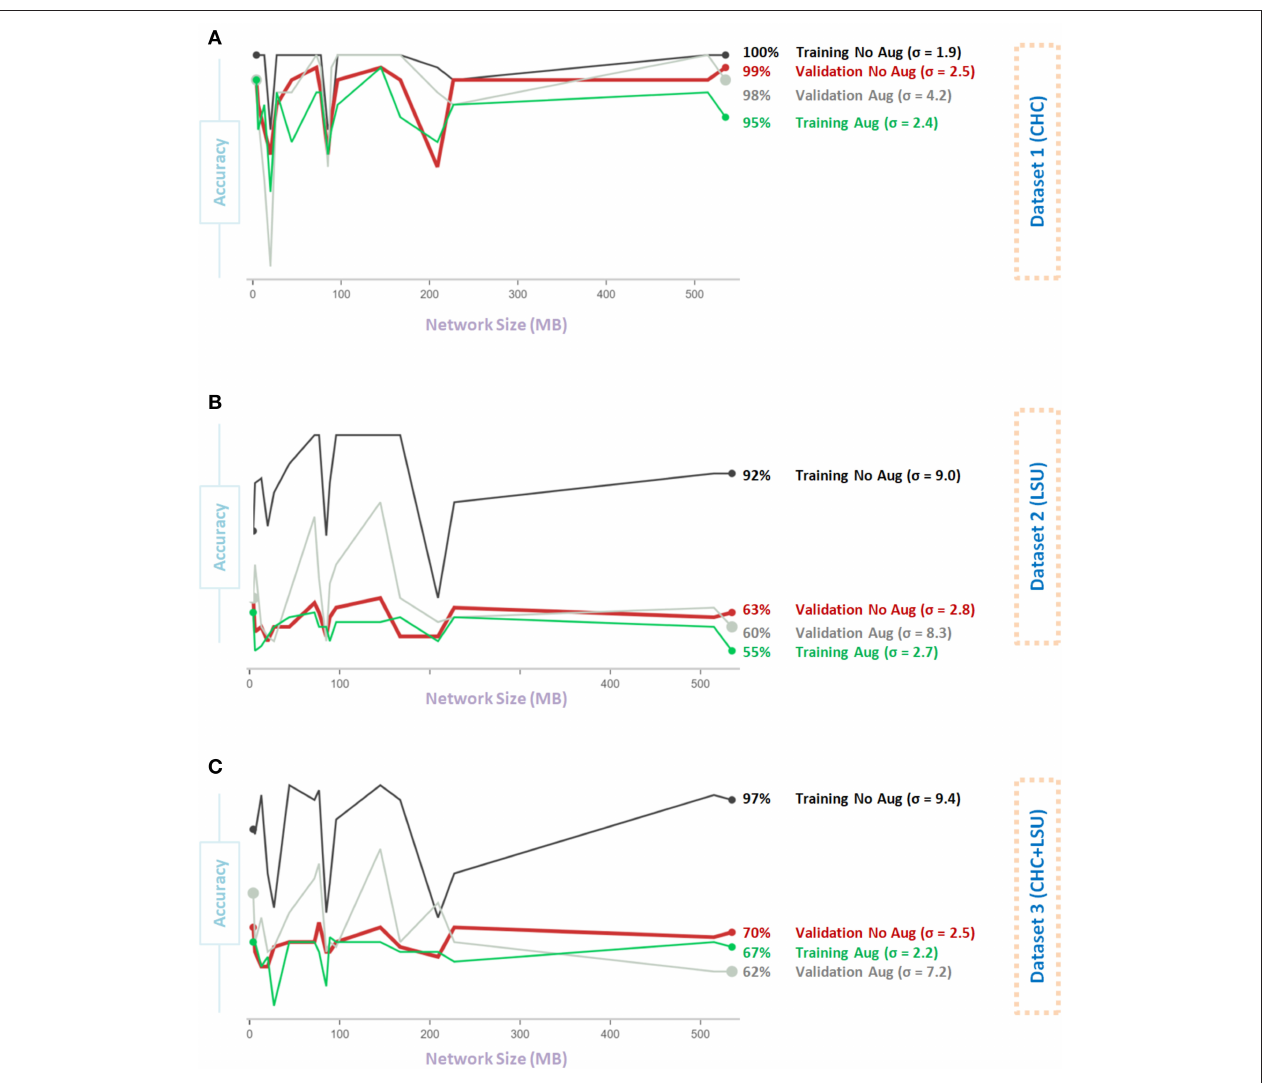
FIGURE 5 | Effect of network size on Data Augmentation 4 (6) for detecting X-ray images with and without COVID-19. (A) CHC Dataset. (B) LSU Dataset. (C) CHC+LSU Dataset. Here, σ refers to standard deviation of performance with respect to network size, which is calculated to measure stability over different network sizes, high value means less